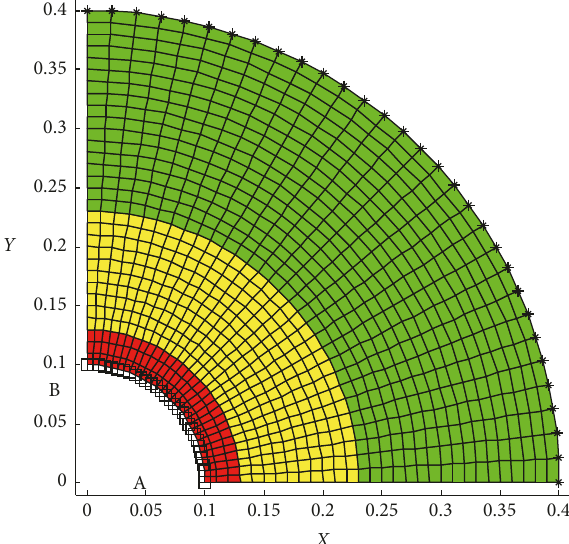
Figure 4: Mesh, geometry, and boundary conditions of the two- dimensional